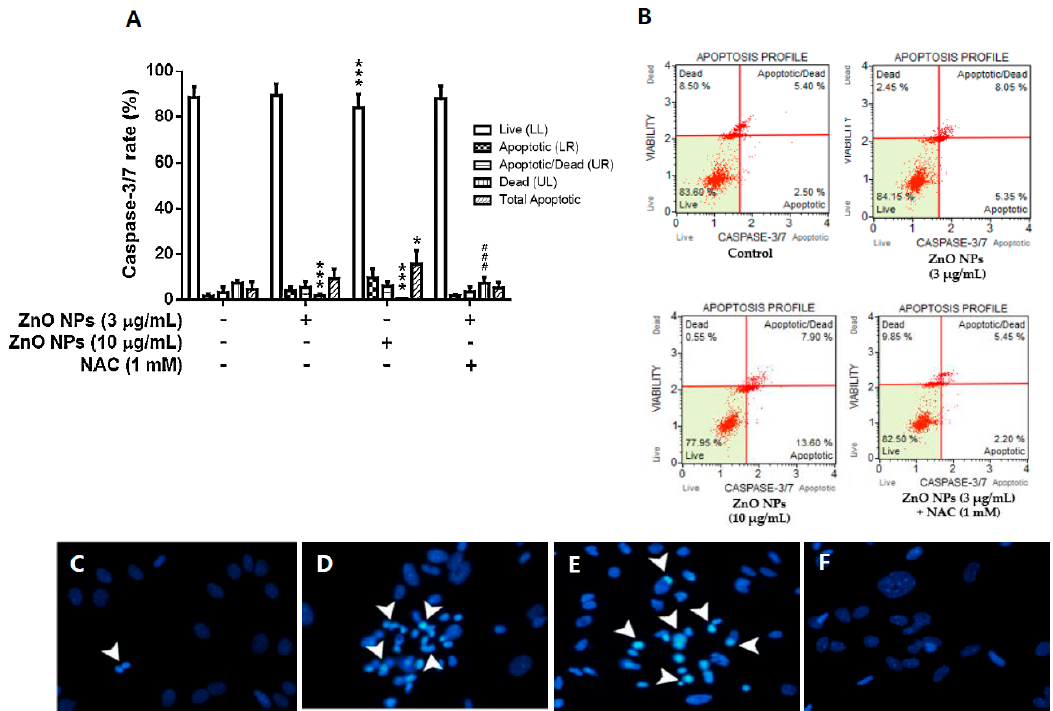
Figure 5. Effects of ZnO NPs on apoptosis profiles (live, apoptotic, apoptotic/dead, dead, and total apoptotic) of primary cultured astrocyte cells. ( A ). Representative flow cytometry data for the